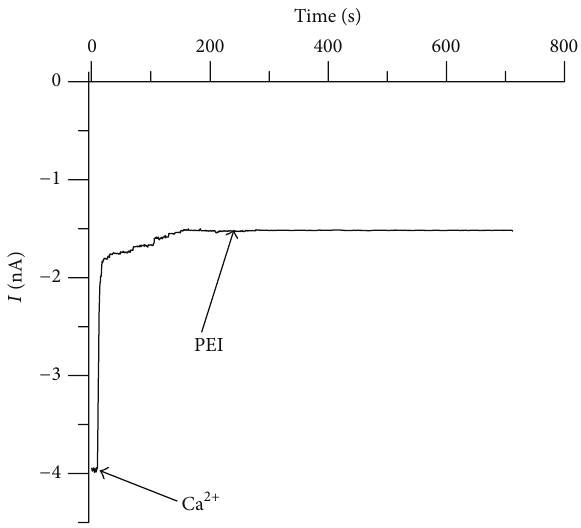
Figure 4: PEI and multivalent ions compete for the binding sites present within the channel structure. PEI (10 𝜇 M final concen- tration) lack the inhibitory capabilities when the binding sites of lysenin have been previously blocked by the addition of Ca 2+ (40mM final concentration).